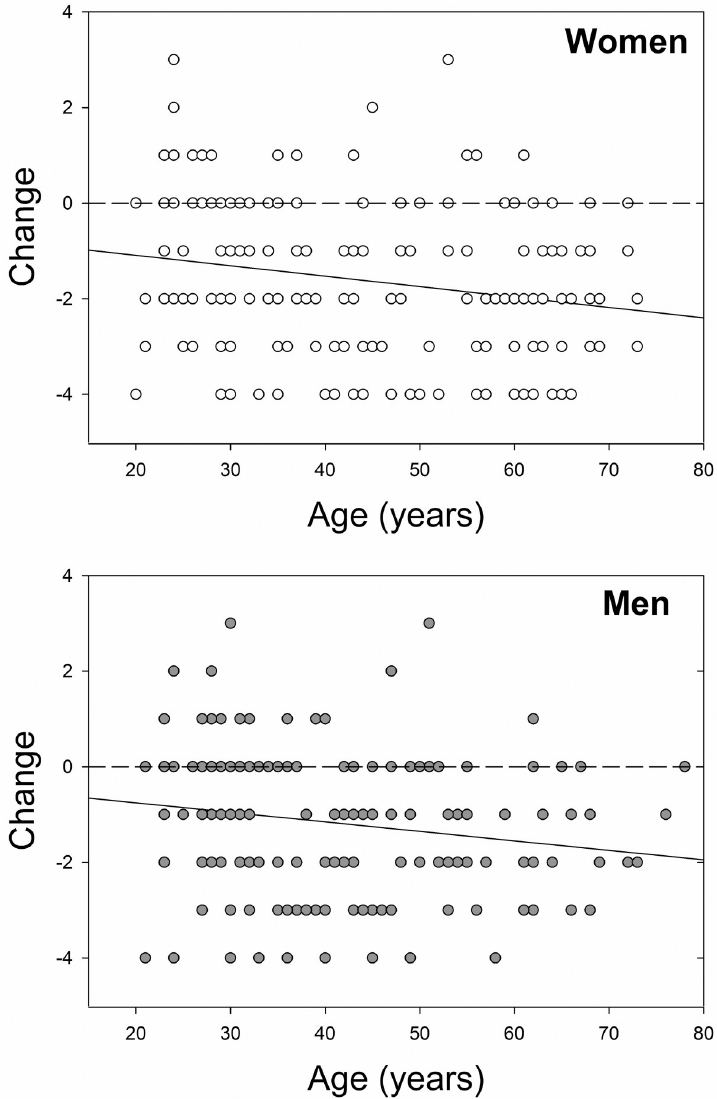
Fig 3. Change in frequency of close proximity encounters ( Δ Proximity) as functions of age for female (top panel) and male (bottom panel) participants. Note that because of the categorical nature of our frequency measure, some symbols represent data from more than one